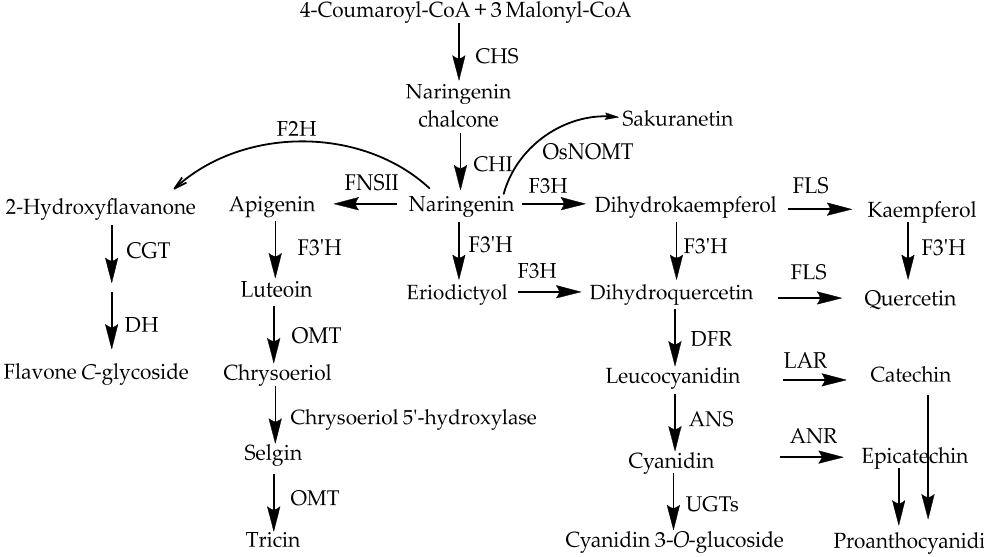
Figure 10. Proposed biosynthesis pathway of rice flavonoids [124]. Abbreviations: CHS, chalcone